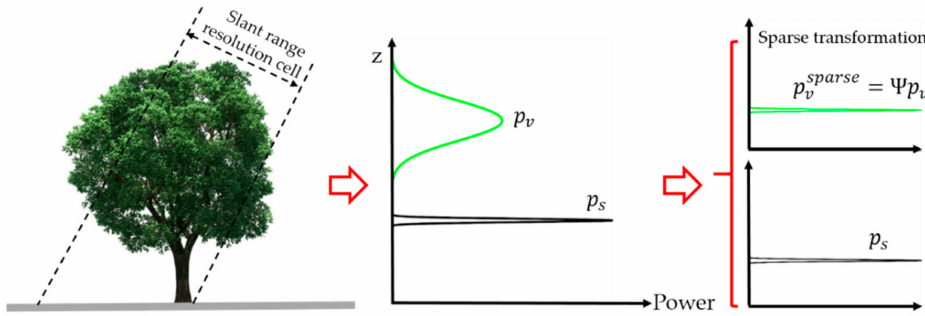
Figure 1. The sparse transformation of backscattering power over forest